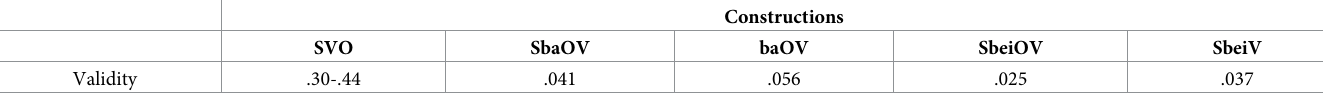
Table 1. Cue validity for transitive constructions in Mandarin